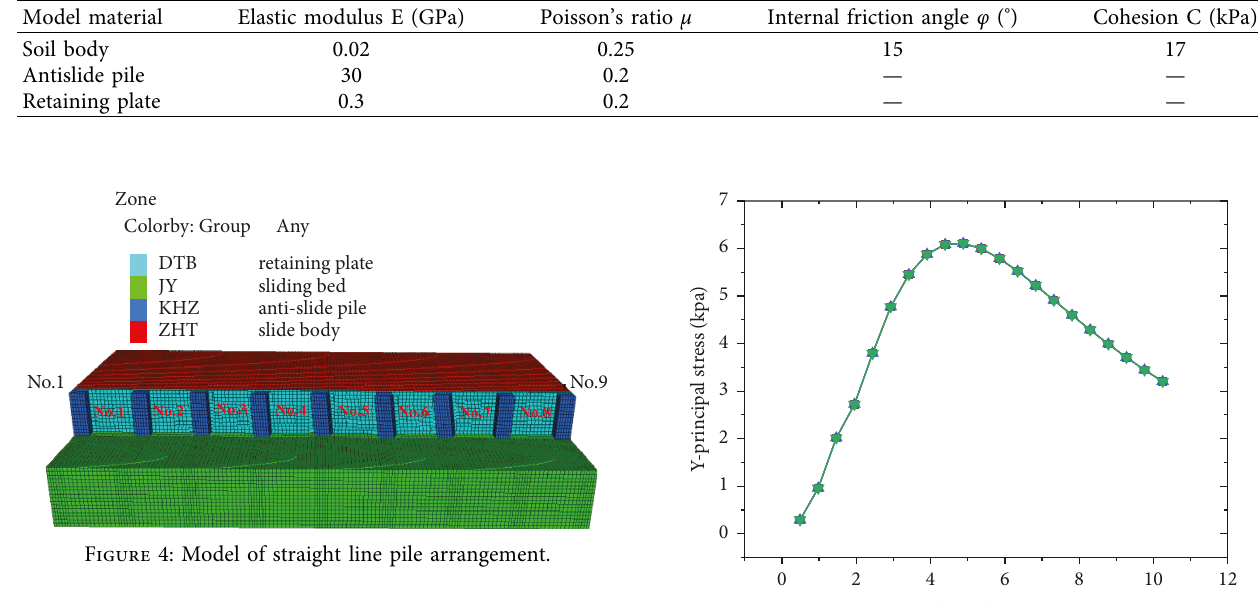
Table 1: Physicomechanical parameters of materials.